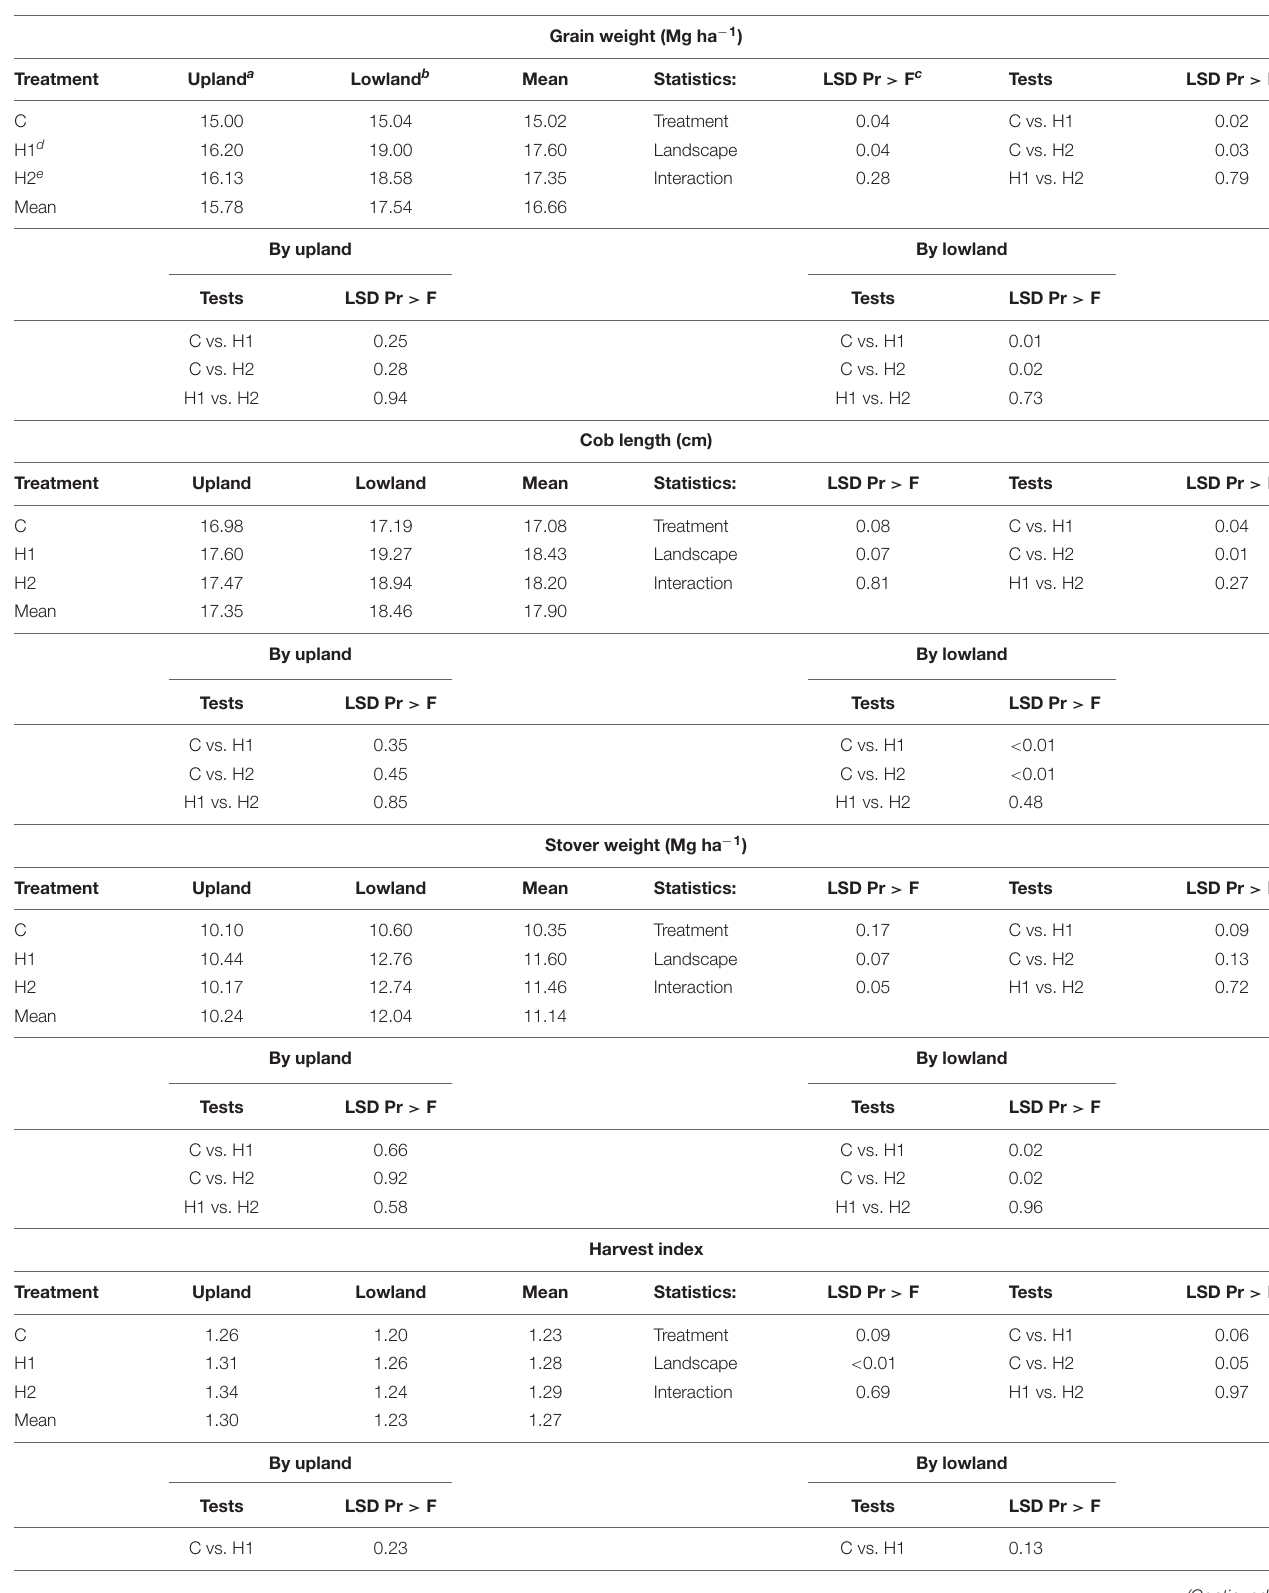
TABLE 5 | Maize yield component responses to humic product application for the Kelley on-farm field trial (2013).